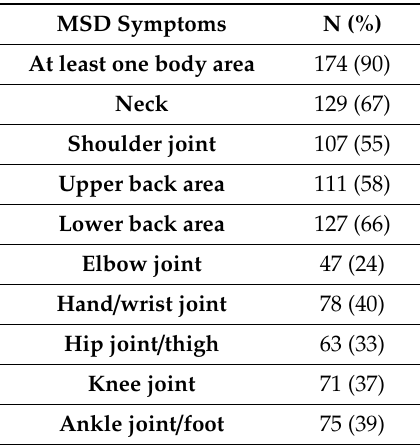
Table 3. Prevalence of musculoskeletal disorder (MSD) symptoms with respect to body region in the previous 12